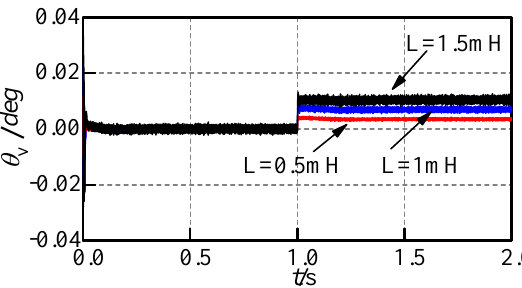
j n I rj Figure 10. Block diagram of the entire system control scheme.